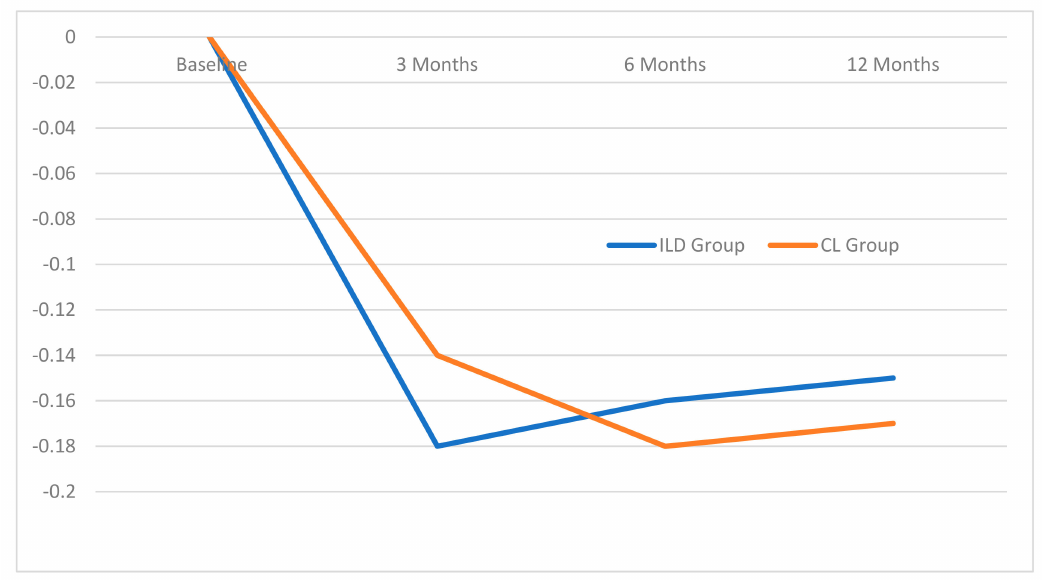
Figure 5. Marginal bone levels at the 3, 6 and 12-month intervals.